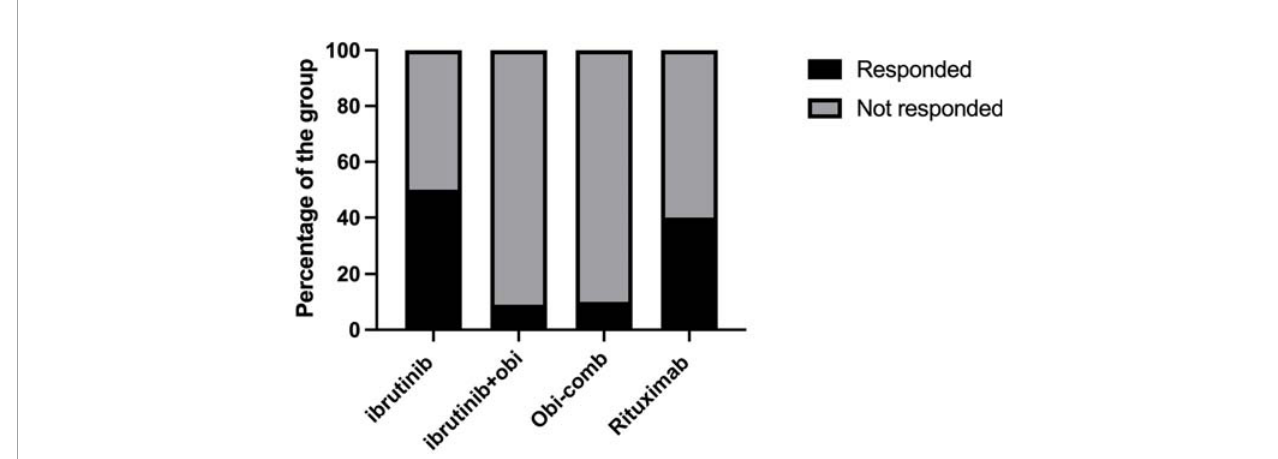
FIGURE 1 | Effects of anti-cancer treatment on SARS-CoV-2 vaccination response. Obi, Obinutuzumab; Obi-Comb, Obinutuzumab+Venetoclax or Obinituzumab +venetoclax+ibrutinib.